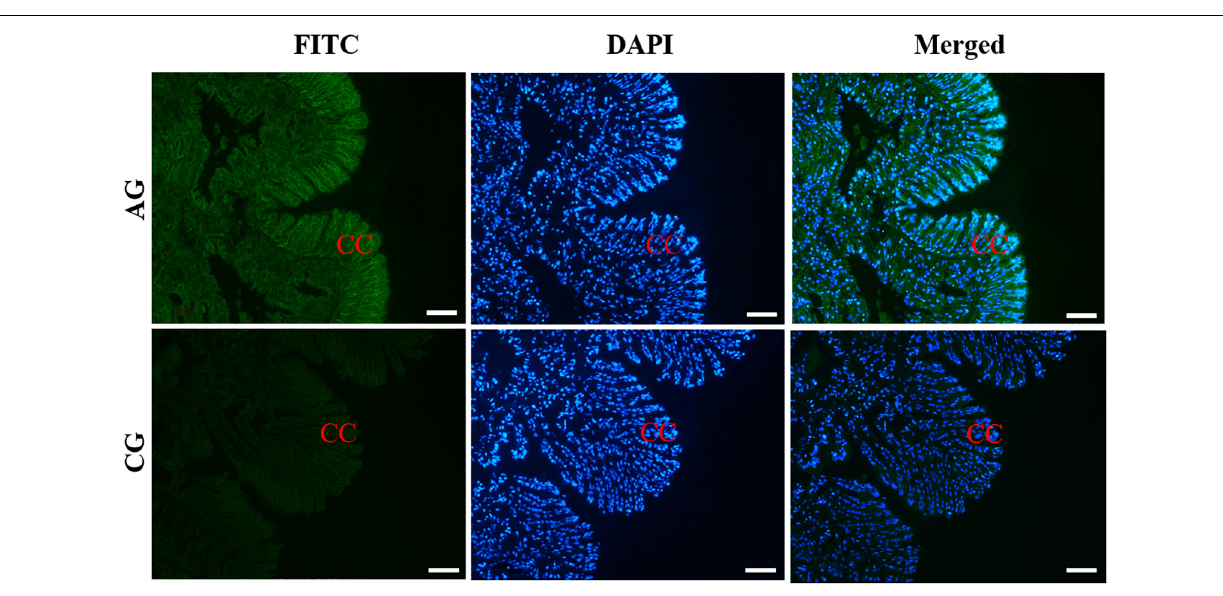
( Figure 2B ). On this basis, Sc-GDH was detected in endothelial cells of hepatic sinusoid in AG and showed positive signal, ( Figure 4 ). The combination diagram showed that the green and the blue signal did not coincide, indicating that Sc-GDH was